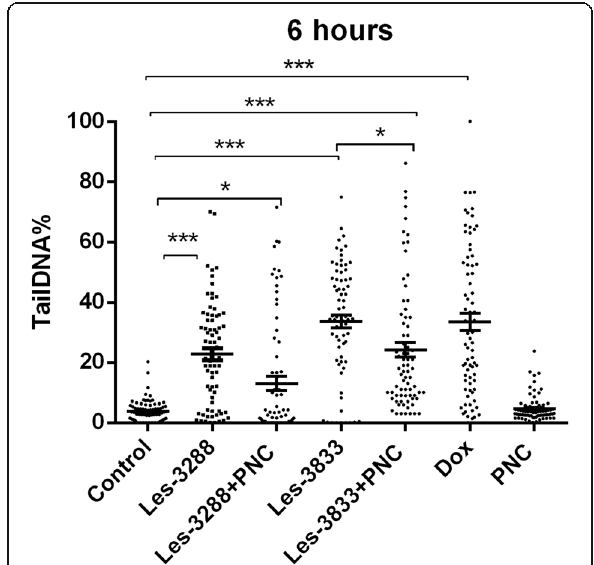
Fig. 14 DNA damage evaluated using the % of DNA in comet tail of C6 rat glioma cells treated with experimental antineoplastic compounds during 6 h at a concentration of 0.5 μ g/mL. * P ≤ 0.05; ** P ≤ 0.01; *** P ≤ 0.001. PNC, polymeric nanocarrier;